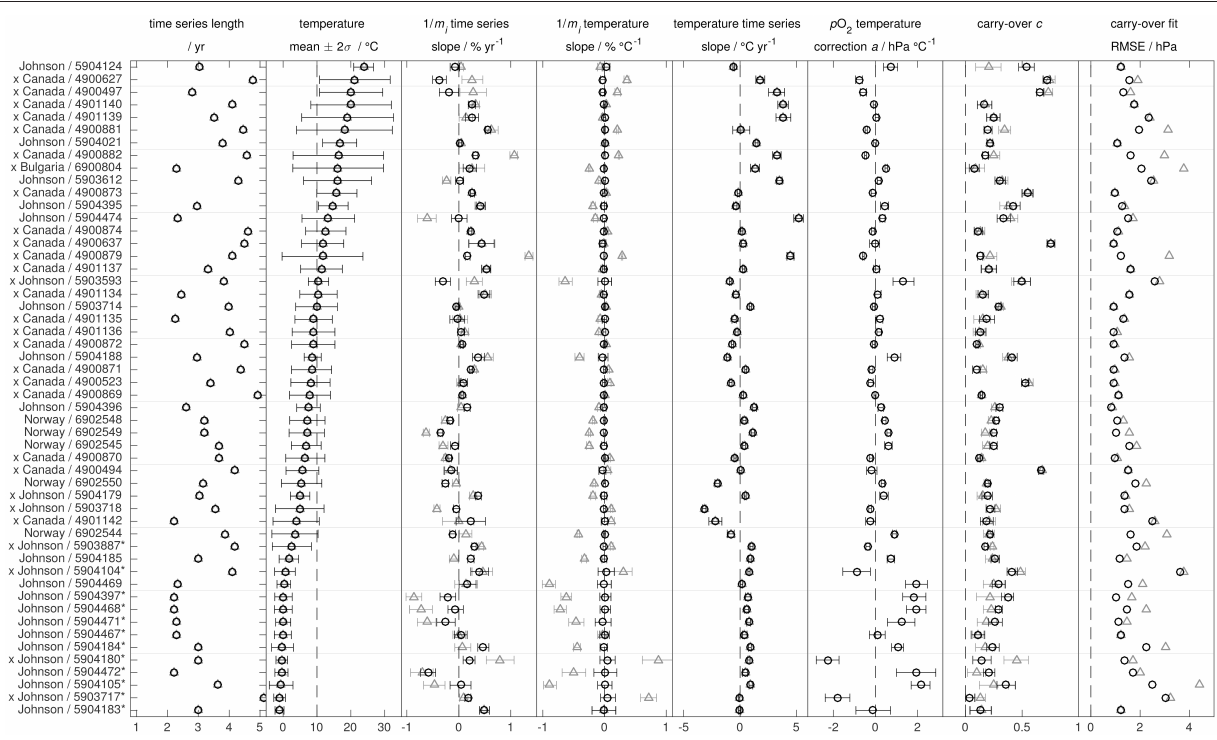
particular to reduce uncertainties for the air sea difference of O 2